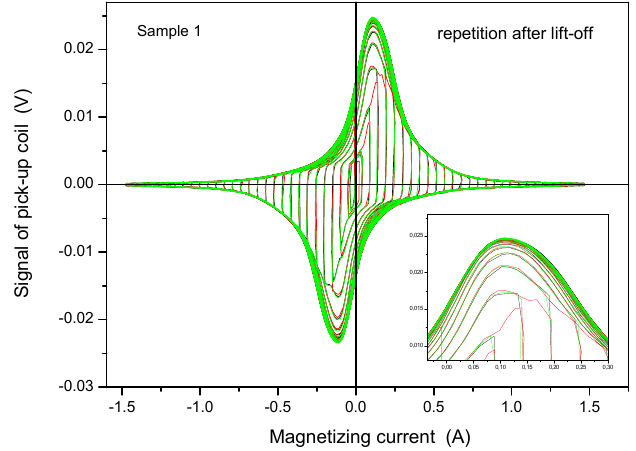
Figure A2. Series of permeability loops measured on sample 1 after reposition the magnetizing yoke. Insert: magnified part of the graph.